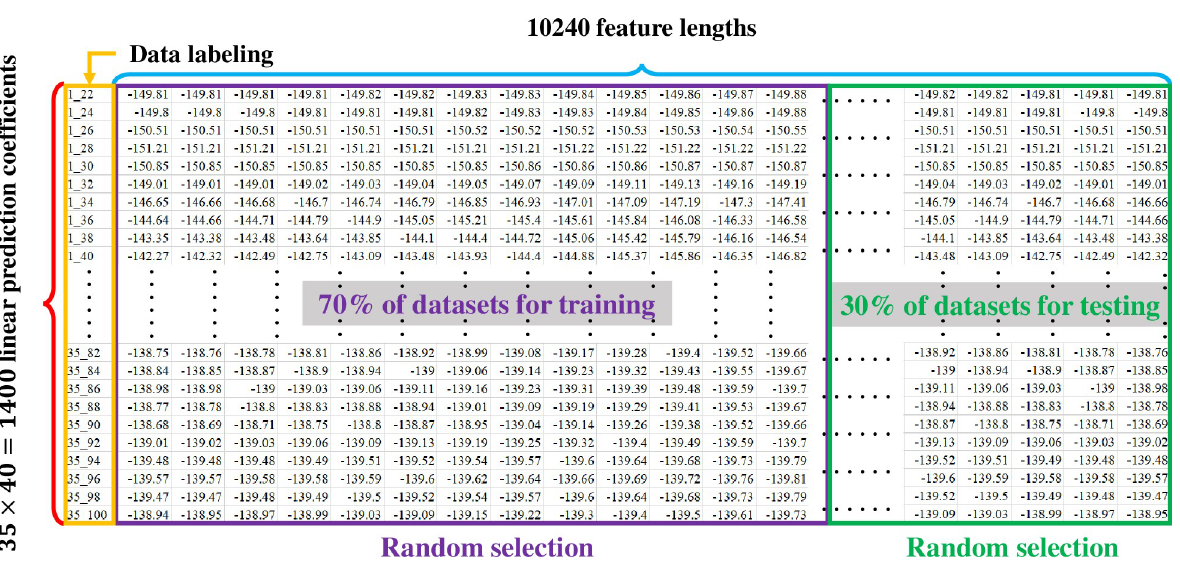
Fig 12. The label establishment of 35 anuran datasets through bioacoustic spectral features filtered by an LPC algorithm. The label in the first column, X_YY, indicates the X-th anura with linear prediction coefficient equal to YY. MFCC also uses similar data labeling and data model construction methods to generate 10240 feature lengths corresponding to the 40 pre-emphasis coefficients. The two datasets are divided into two parts in the machine learning classification stage. The experiment randomly selects 70% of the datasets for training, with the remaining 30% used for